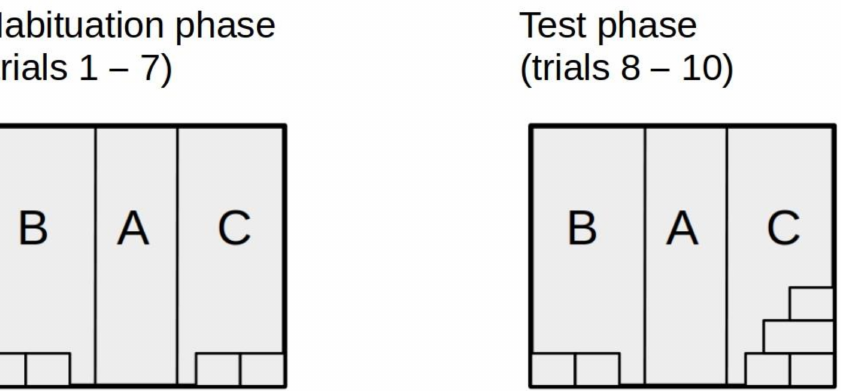
Figure 3. The arrangement of objects in the experimental chamber in each experimental setting. Habituation phase—two tunnels placed next to each other in sections B and C; Test phase—two tunnels placed next to each other in section B and two tunnels placed next to each other and an additional two tunnels placed at the top in section